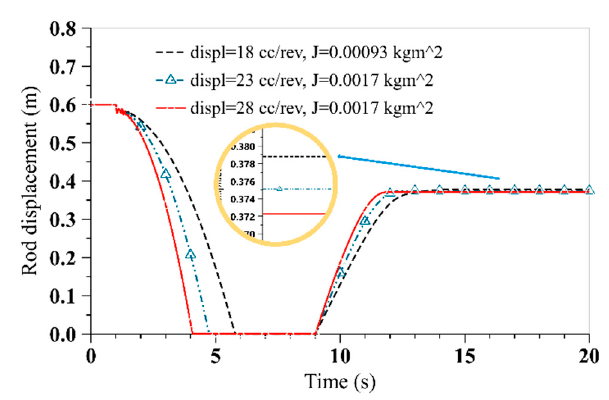
Figure 23. Energy stored in the flywheel at different PM displacements.